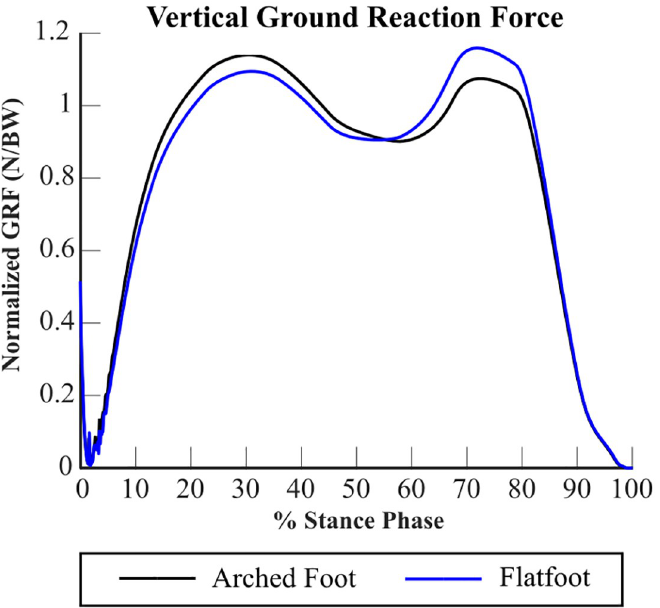
Fig 9. Vertical ground reaction forces. The vertical ground reaction forces generated by simulations of the stance phase of gait with an arched foot (black) and a flatfoot (blue) model.